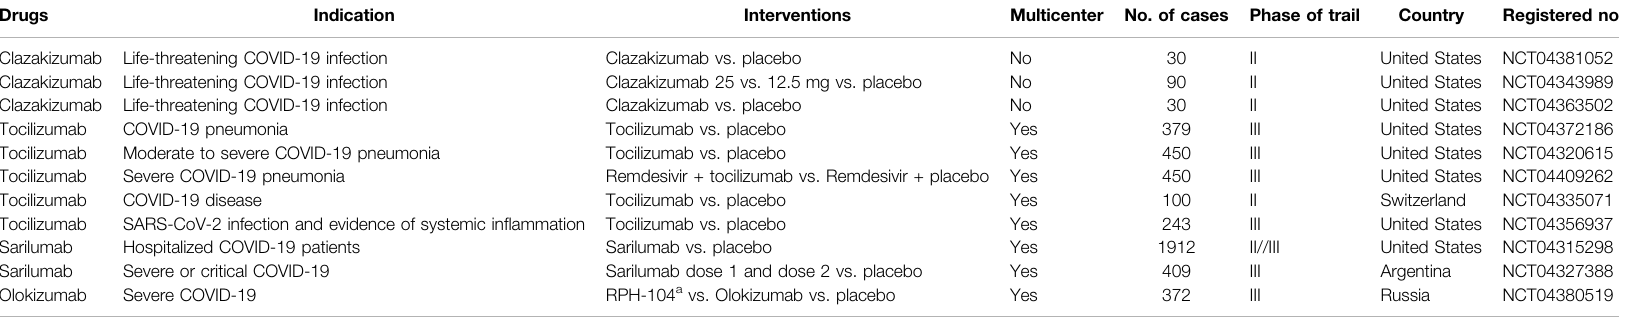
TABLE 1 | Summary of current randomized, placebo-controlled clinical trials of IL-6 inhibitors for COVID-19.